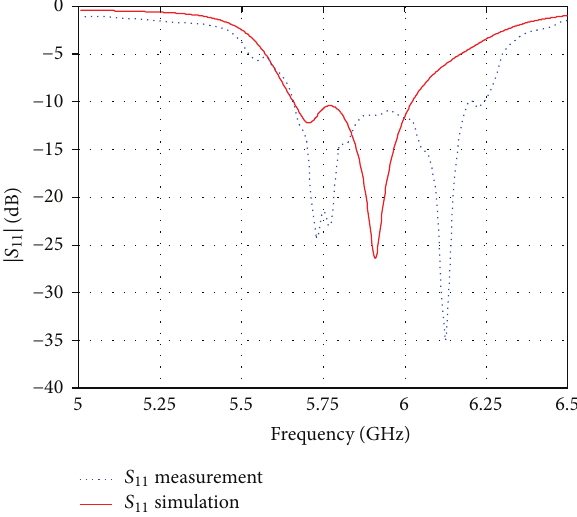
Figure 21: Reflection coefficients of FL-LHM antenna arrays with ℎ = 30 mm in simulation and measurement.